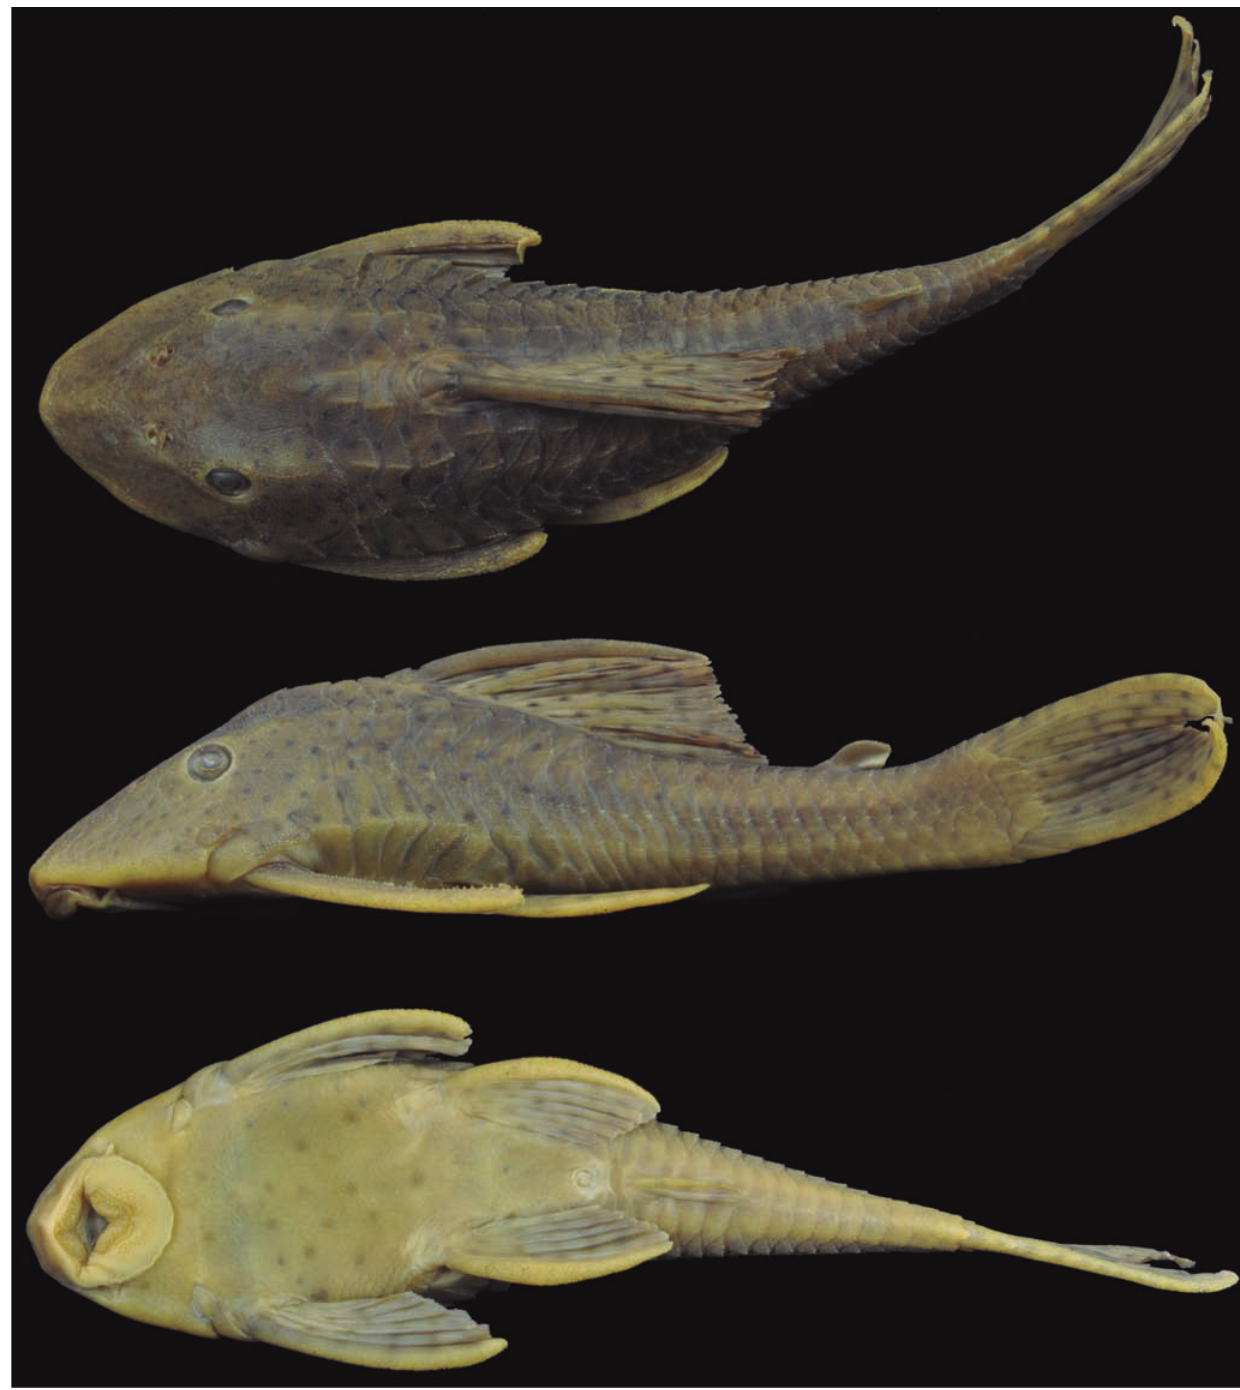
Fig. 13. Hypostomus khimaera , holotype, MZUSP 111129, 139.1 mm SL, from córrego Salobo, rio Paraguay basin, Mato Grosso State, Brazil; dorsal (top), lateral (middle), and ventral (bottom)